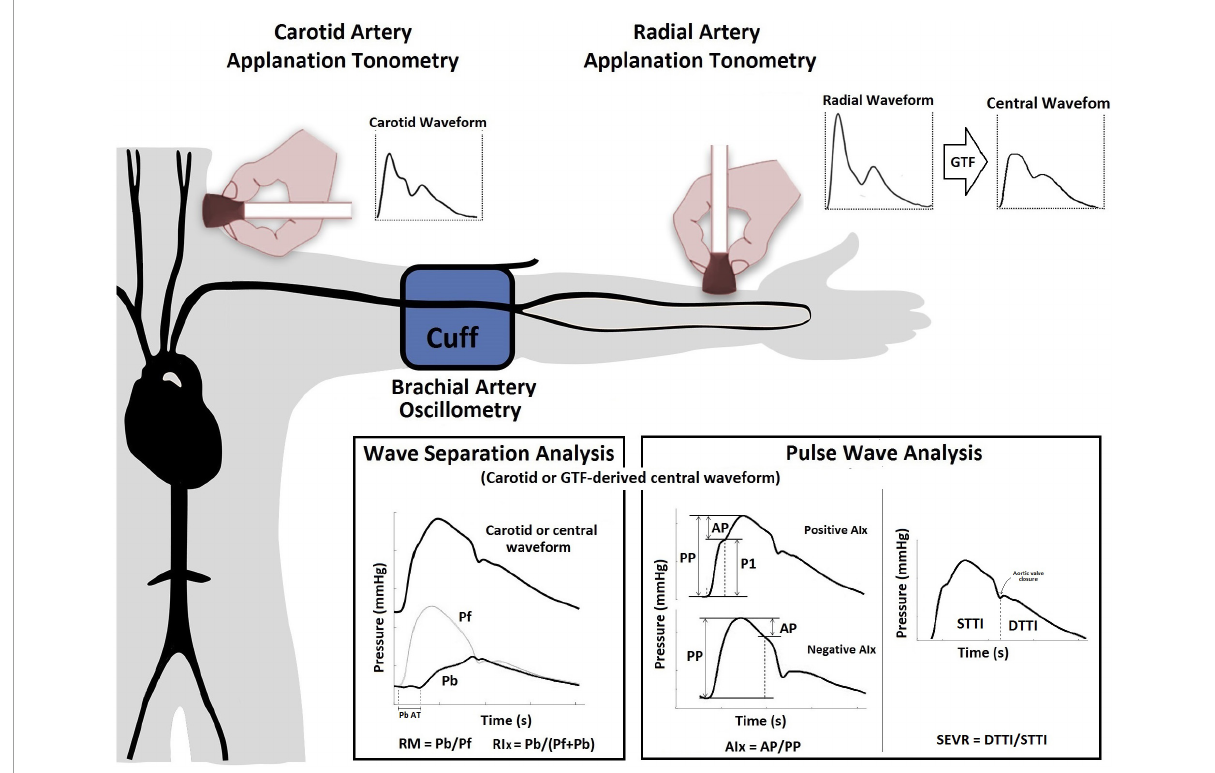
FIGURE1 Use of applanation tonometry (radial or carotid) for the assessment of PWA and WSA. PWA: The AP represents the direct augmentation level caused by wave reflections (a positive AP indicates “additional” pressure arising from wave reflections) (36), and is calculated from the inflection point in the pressure waveform (systolic phase) that "points out or identifies" the arrival of the reflected component to the aortic root (37). AIx (either a positive or negative value) is calculated as AP/aoPP and is considered a surrogate index of wave reflection, although it also depends on factors like HR, vascular tone, or LV function (22). SEVR, quantified as the ratio between aortic diastolic and systolic tension-time areas or indexes [STTI and DTTI], represents a parameter of myocardial oxygen supply and demand that can be altered by changes in diastolic and systolic pressures as a result of changes in the arrival of the backward pulse wave (16). WSA: The Pf represents the integration of the forward wave arising from the ventricle and re-reflections of backward propagating waves at the ventricular-aorta interface. Using Pf and Pb, the reflection magnitude (RM = Pb/Pf) and index [RIx = (Pb/(Pf + Pb)] can be obtained (13, 38). Abbreviations as in